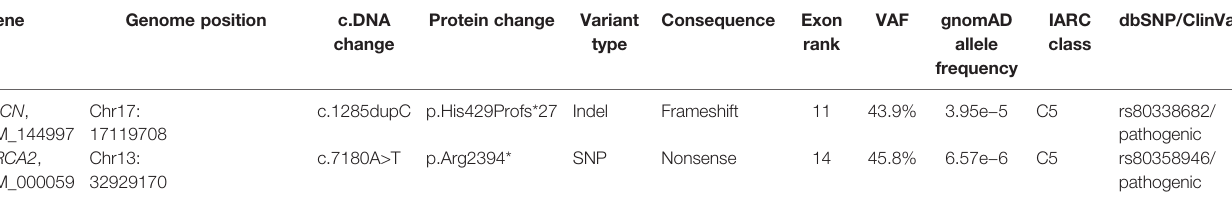
TABLE 6 | List and details of pathogenic FLCN and BRCA2 variants detected in the family.